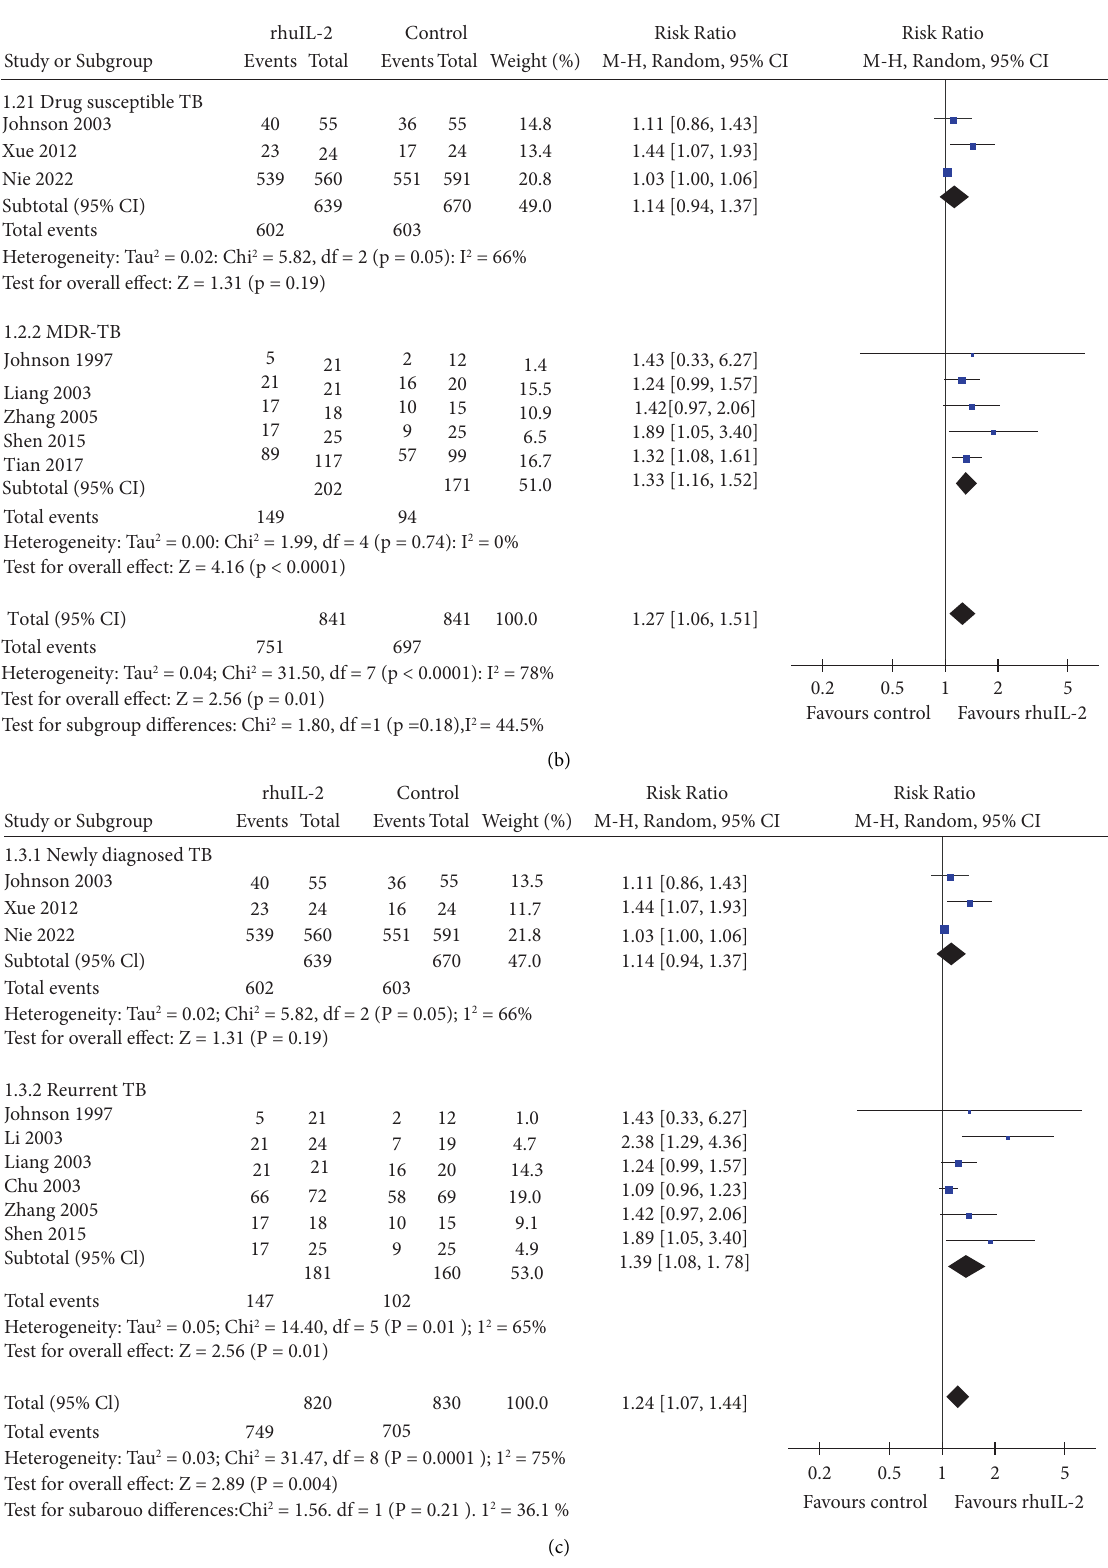
Figure 2: Forest plots for the meta-analysis of the efect of rhuIL-2 on the proportion of patients with sputum culture conversion to negative; (a), forest plots for the overall meta-analysis; (b), forest plots for the subgroup analysis according to the drug sensitivity of TB; and (c), forest plots for the subgroup analysis in newly diagnosed and recurrent